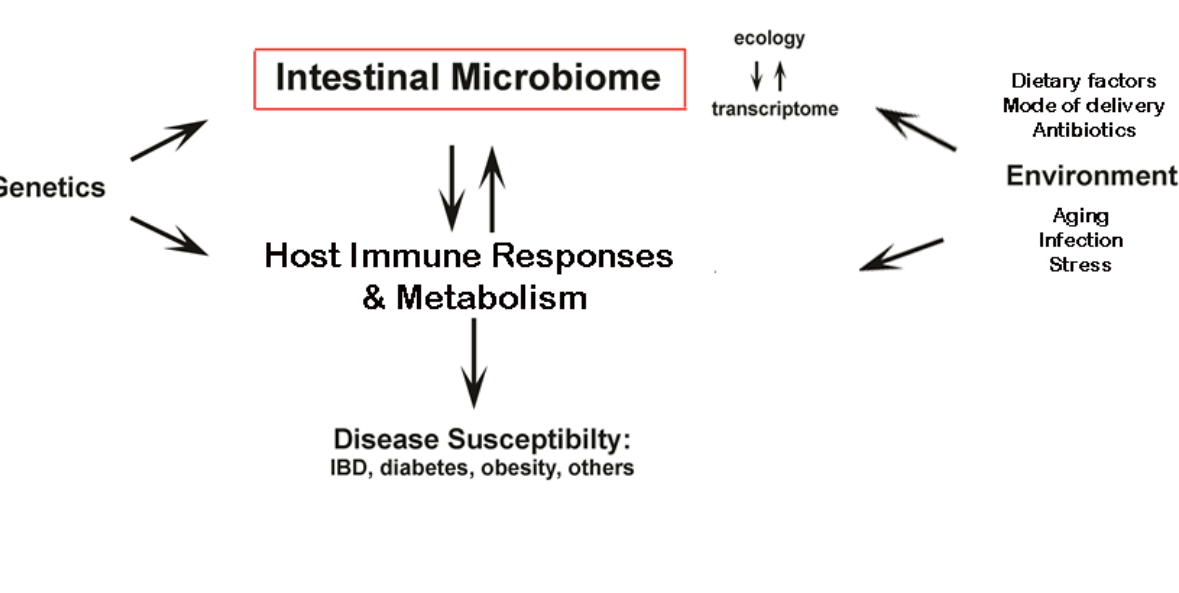
Figure 1. Diet-induced dysbiosis affects disease susceptibility. The intestinal microbiome (microbial ecology and their genetic material) is influenced by both host genetics and the environment including dietary factors. In diseases including IBD, diabetes and obesity, diet is implicated as a contributing factor by having direct effects on host metabolism and/or immune responses. However, recent evidence suggests that diet also influences the composition of the microbiome. This could, in turn, affect host immunity and metabolism and alter susceptibility to